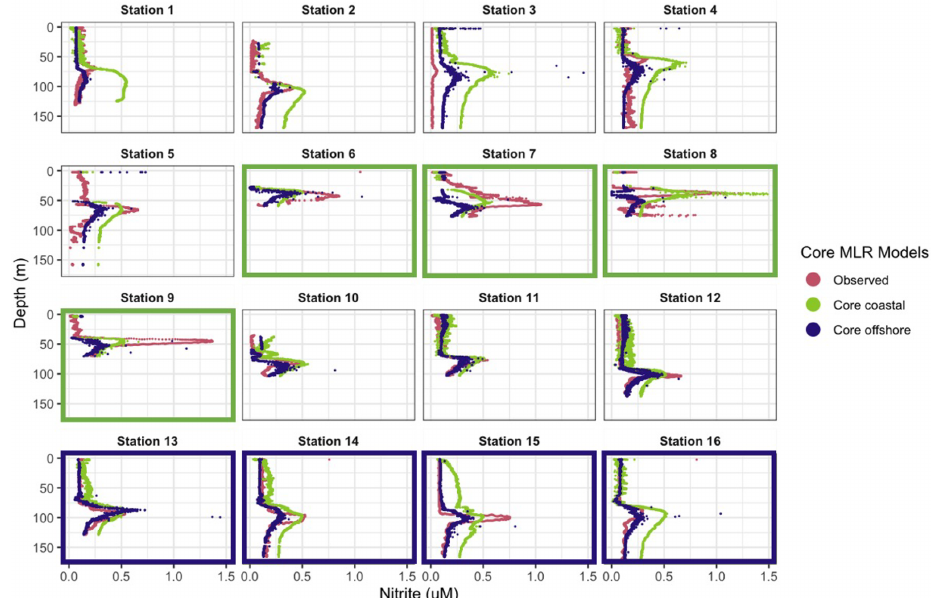
Figure 6. Predicted nitrite profiles from “core” coastal MLR (green) and offshore MLR (blue). Observed nitrite profiles from PPS 2016 dataset (magenta). Panels of stations used to train the coastal model are traced in green, and panels for stations used to train the offshore model are traced in